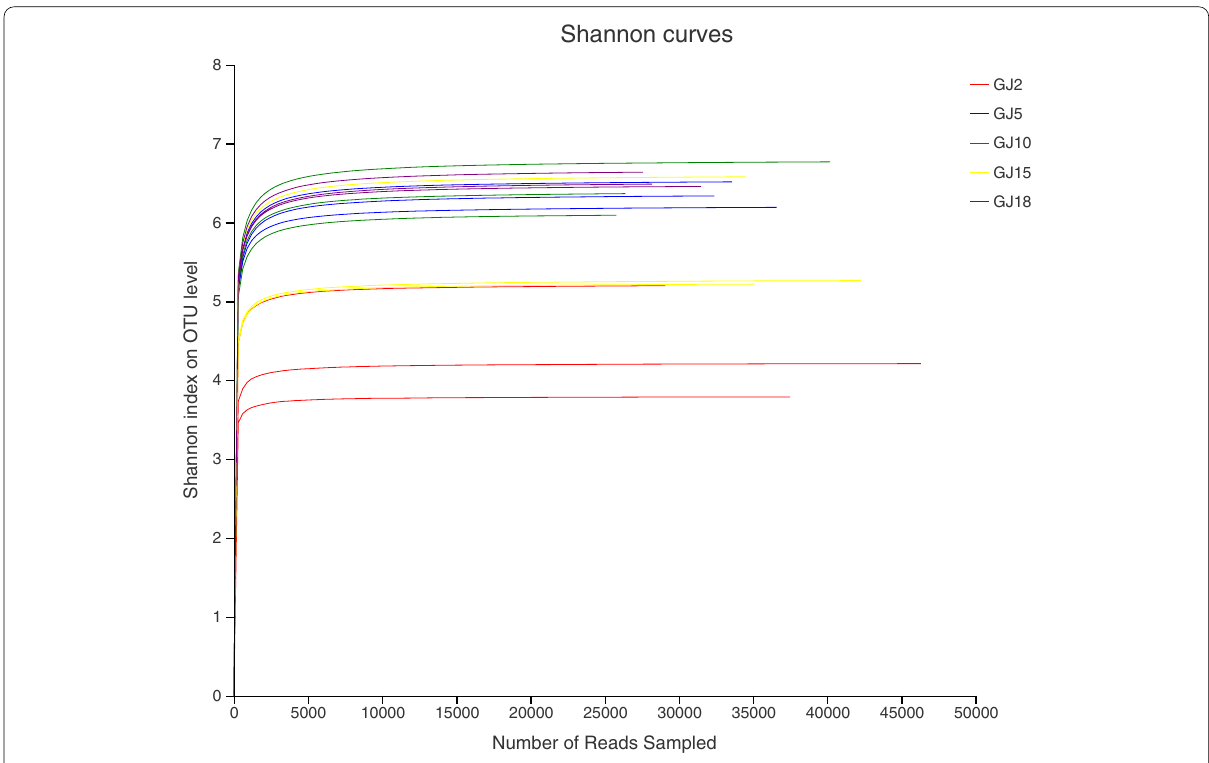
Fig. 2 Shannon curves. GJ2‑18 were the 2–18 year‑old citrus plantations